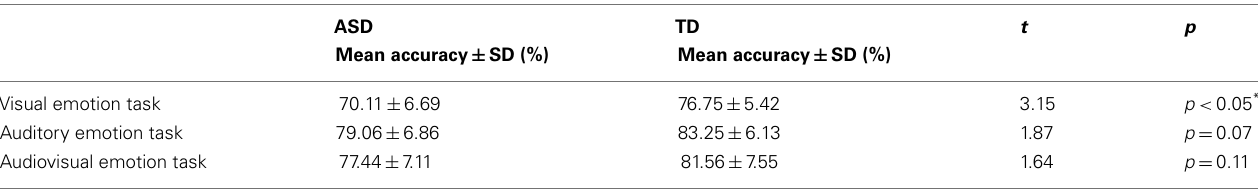
Table 2 |Accuracy scores on emotion matching